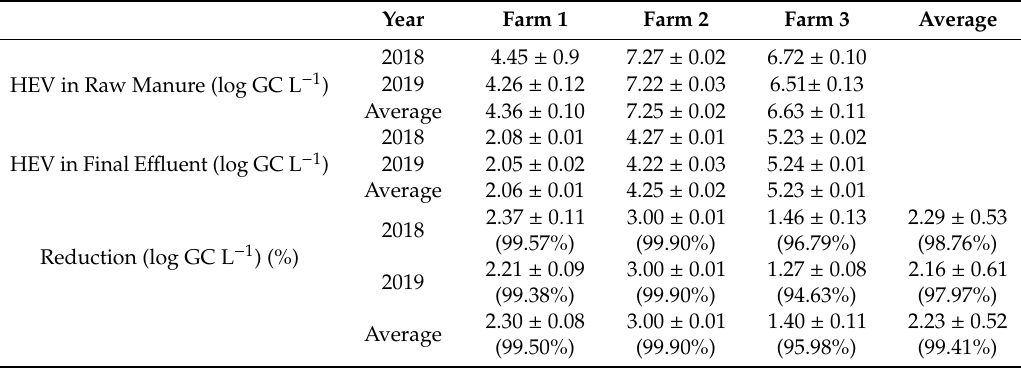
Figure 1. HEV concentration in swine raw manure from maternity, nursery and grow-finish swine production system. GC: genome copies. Table 1. HEV concentration in swine raw manure and swine effluent after digestion in psychrophilic anaerobic biodigesters, as well the reduction after treatment. GC: genome copies. Values are represented as Mean ± Standard Error.